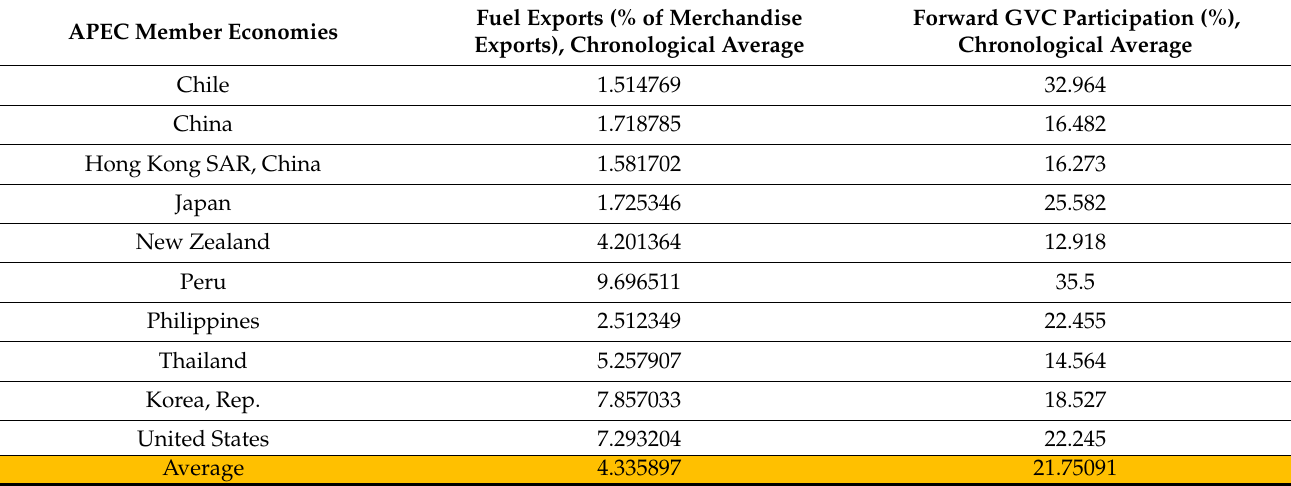
Table 13. APEC member economies with low percentage of fuel exports in merchandise